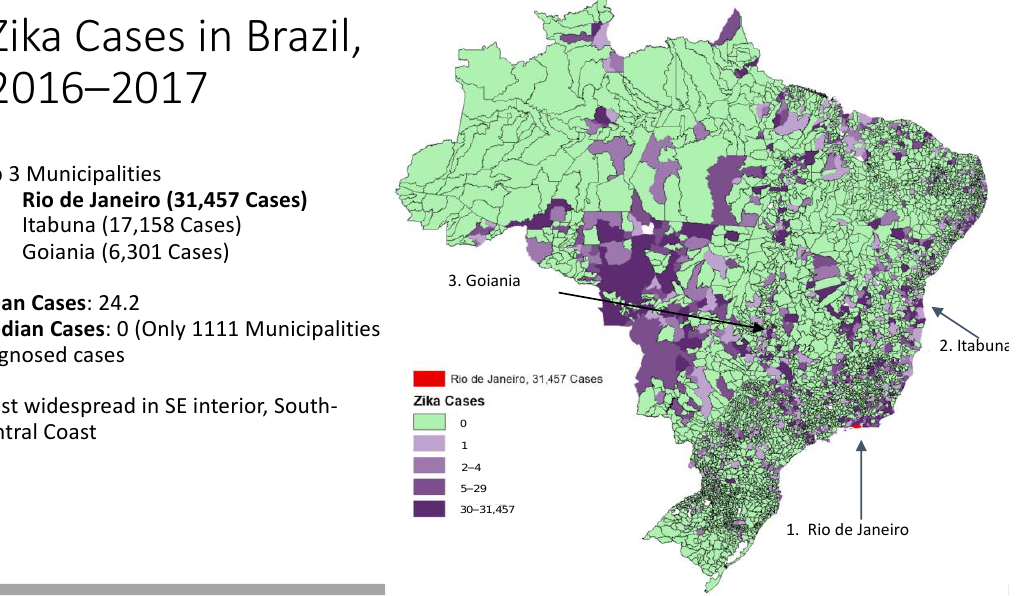
Figure 1. Zika Cases in Brazil, 2016–2017. Figure 2 showcases the sub-municipal distribution of raw Zika cases in one munici- pality, Rio de Janeiro, to demonstrate the granularity of our unique dataset and its added value for other researchers.